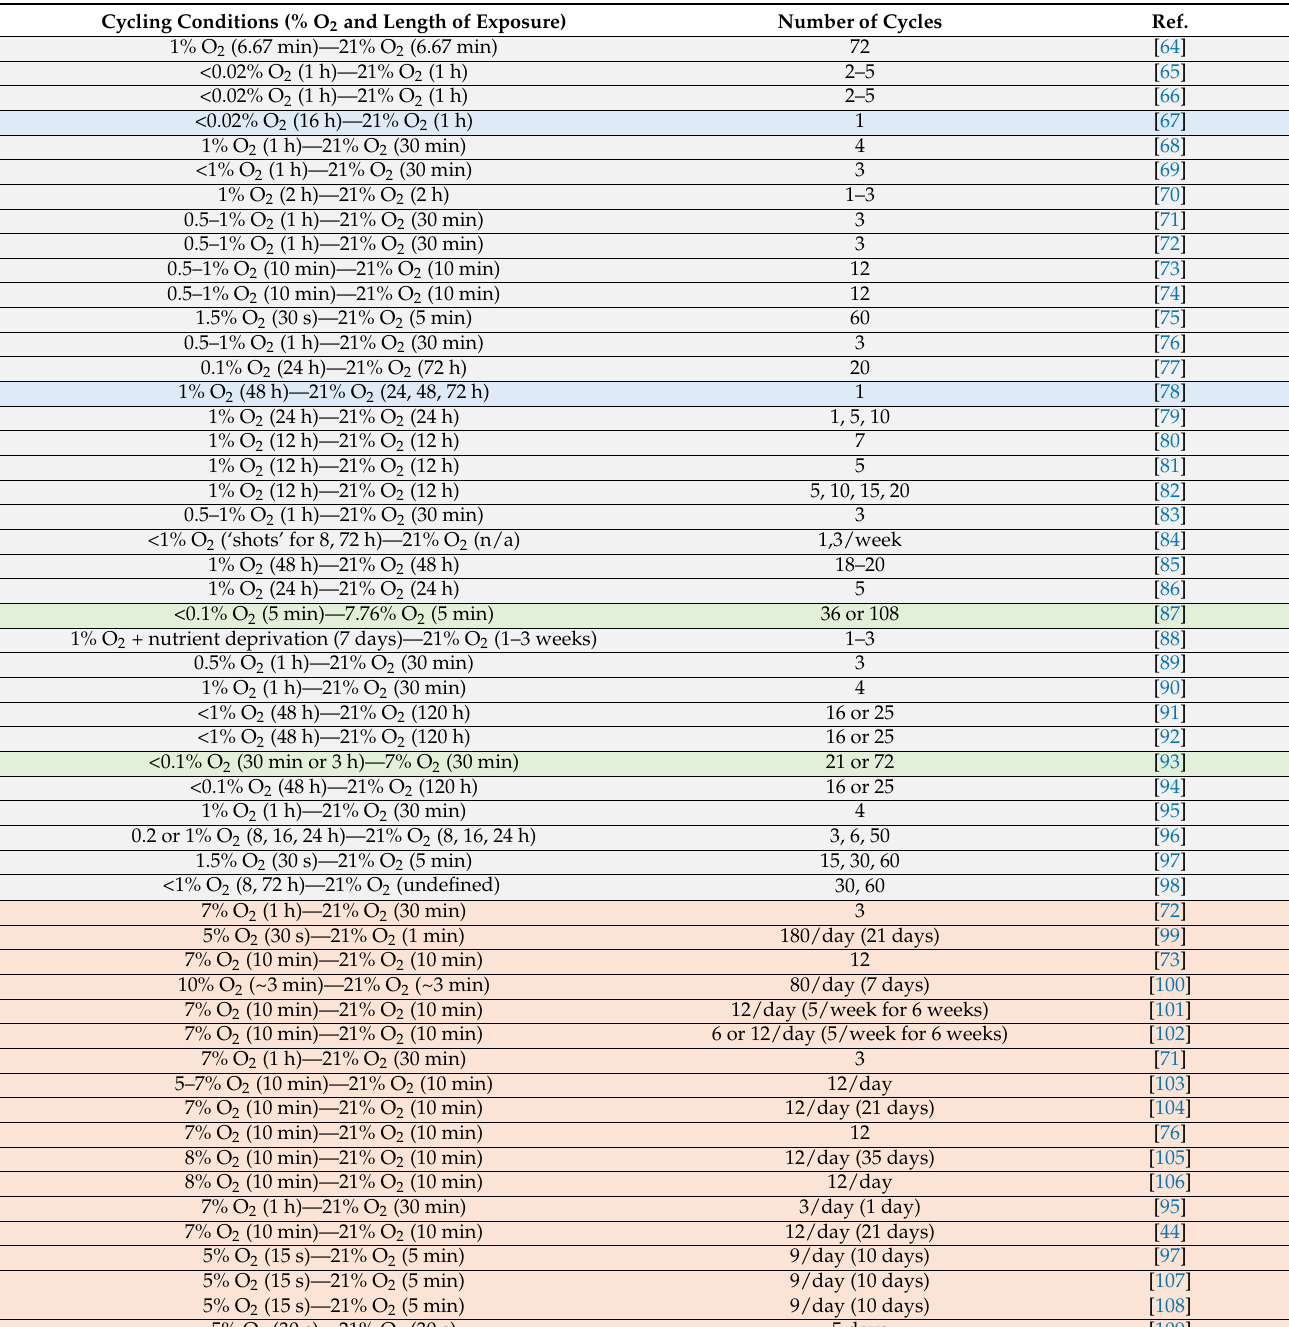
Table 2. Summary of published studies describing cyclic hypoxia. Studies highlight in grey are in vitro studies which include reoxygenation to 21% O 2 . Studies in blue are those that include reoxygenation to 21% O 2 but do not include multiple cycles i.e., a single reoxygenation event. Those in green are in vitro cyclic hypoxia studies that include cycling between two physiologically relevant oxygen concentrations. Finally, those in orange are in vivo studies and indicate the concentration of oxygen in the air the mice were given to breathe and for how